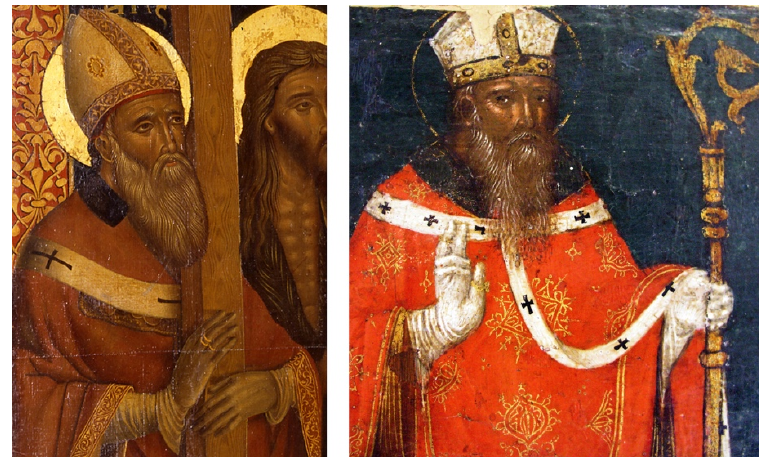
Figure 8. Angelos Bitzamanos. Saint Cyriacus (detail from the Scottivoli altarpiece), 1508. Vatican City, Apostolic Palace ( left ) © Musei Vaticani. Reproduced with permission; Angelos Bitzamanos, Saint Blaise (detail from the altarpiece of Komolac), 1518. Dubrovnik, Franjevački Samostan ( right ). Author’s photos; Figure created by author.